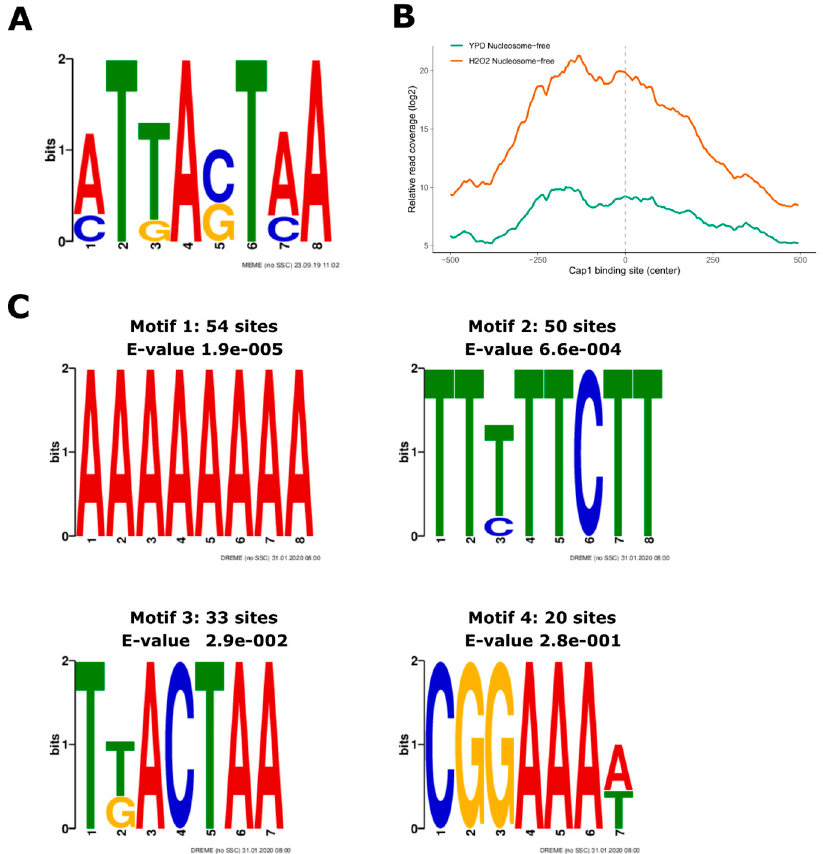
Figure 4. De novo motif search in oxidative stress-responsive nucleosome-free ATAC-seq peaks. ( A ) Previously identified Cap1 motif [45] used for enrichment analysis in nucleosome-free ATAC-seq peaks with increased signal in H 2 O 2 -treated cells. ( B ) Cap1 binding sites are enriched for nucleosome-free ATAC-seq fragments in response to H 2 O 2 . Published Cap1 binding sites [45] were used for enrichment analysis within nucleosome-free ATAC-seq peaks. Read coverage in H 2 O 2 -treated and untreated cells around the Cap1 binding sites is shown. ( C ) Logos of position weight matrices from de novo identified motifs occurring in nucleosome-free ATAC-seq peaks in H 2 O 2 -treated cells (see Material and Methods for details). The number of positive matches among the input sequences and the e-value from the MEME suite DREME tool are indicated above each logo. The top four logos are presented.